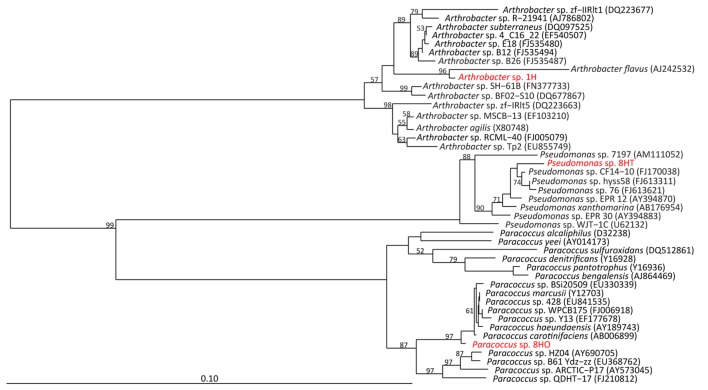
Neighbor-joining tree of full length 16S rRNA gene sequences of isolates (red) to nearest database neighbors (black), based on 1000 bootstrap replicates. Bootstrap values >50% are shown.